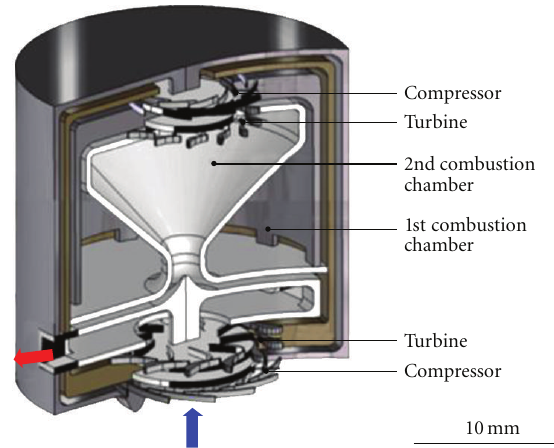
Figure 18: Architecture of the ONERA Micro gas turbine, repro- duced from [50] ONERA, the French Aerospace